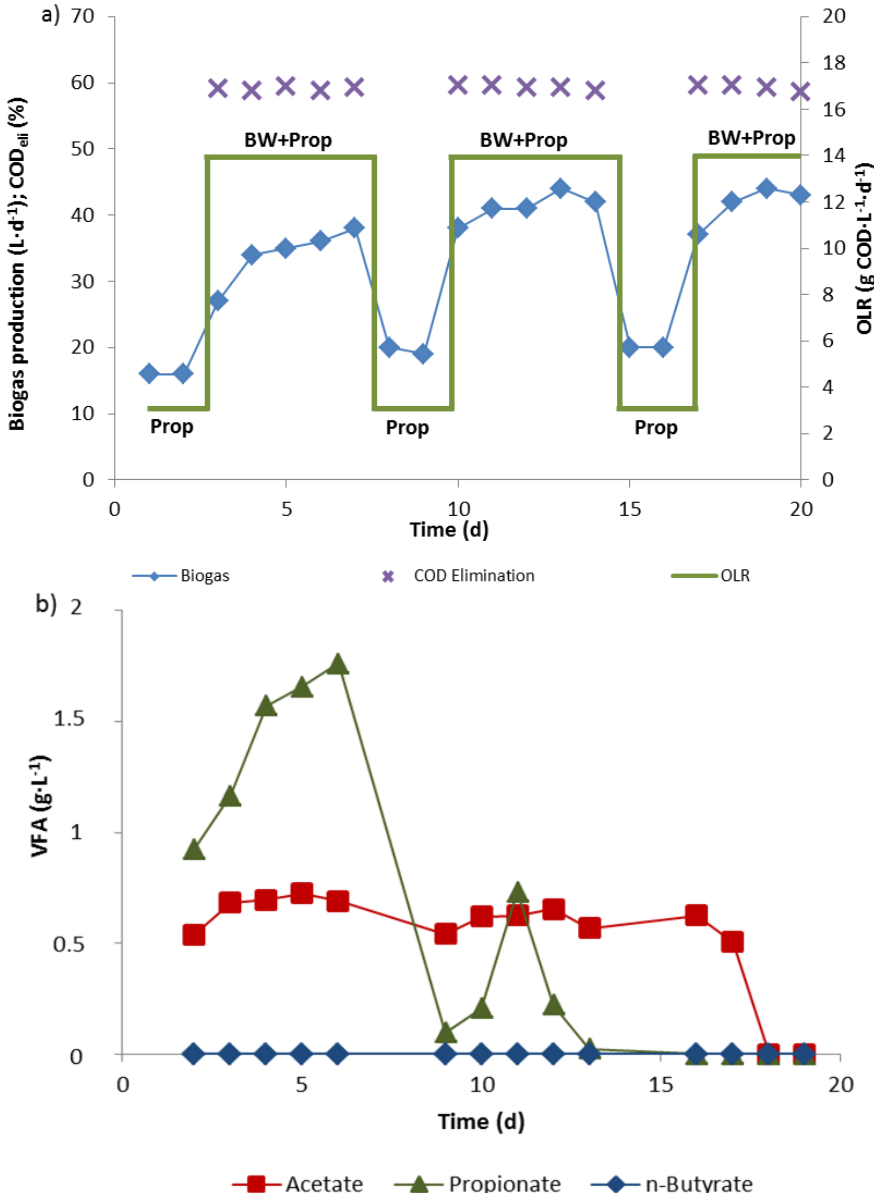
Figure 3. Biogas production ( a ) and fatty acid levels ( b ) in a 10 L biowaste digester (reactor 3) fed constantly with propionate (2.68 mM, 80 mL·d −1 ) at an OLR of 3 kg COD·m −3 ·d −1 and additionally with biowaste from Monday to Friday (1 L·d −1 ) to reach an OLR of 14 kg COD·m −3 ·d −1